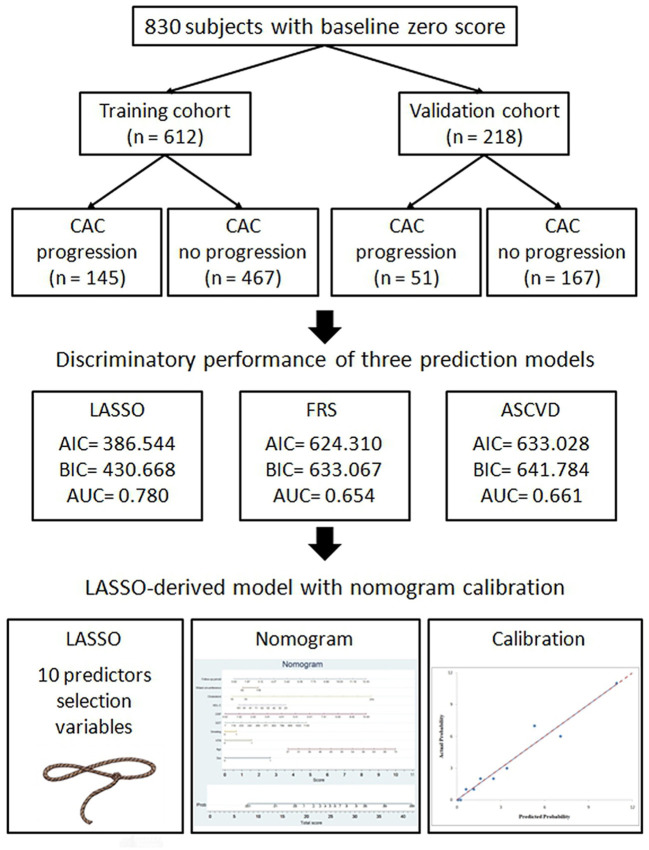
Flow chart of patient selection for the training and validation cohorts.